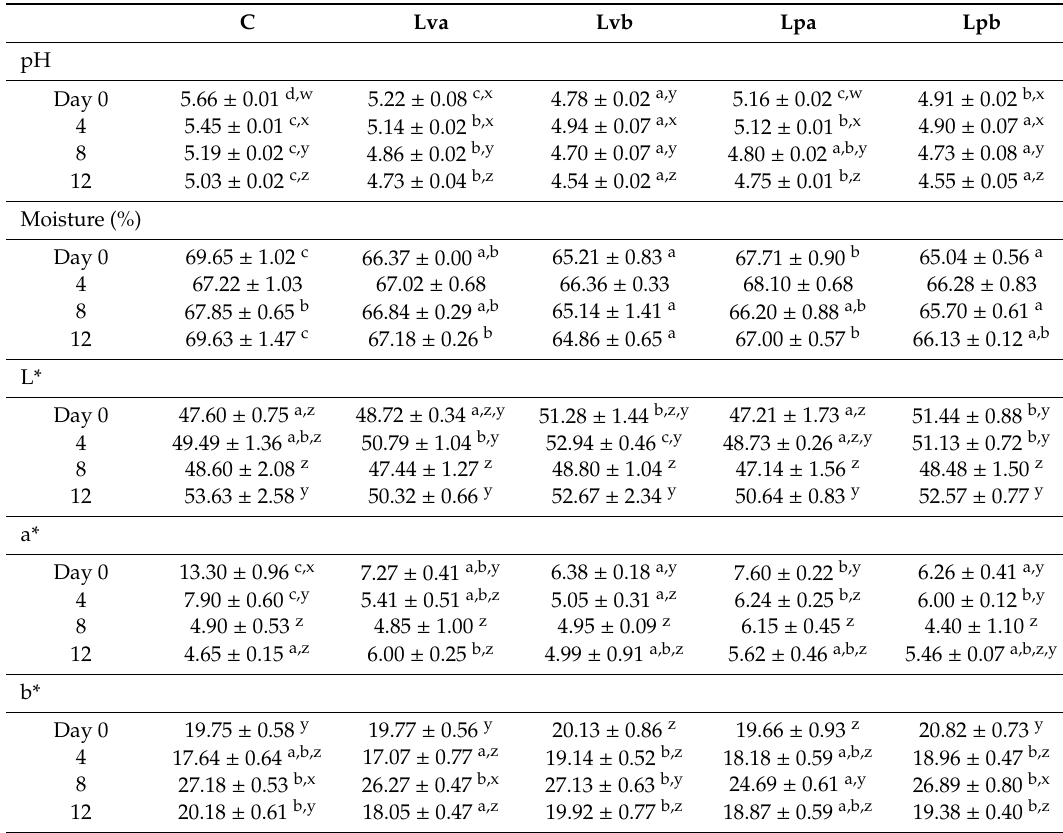
Table 2. Physicochemical and color parameters (mean ± standard deviation) of deer burgers during chilled